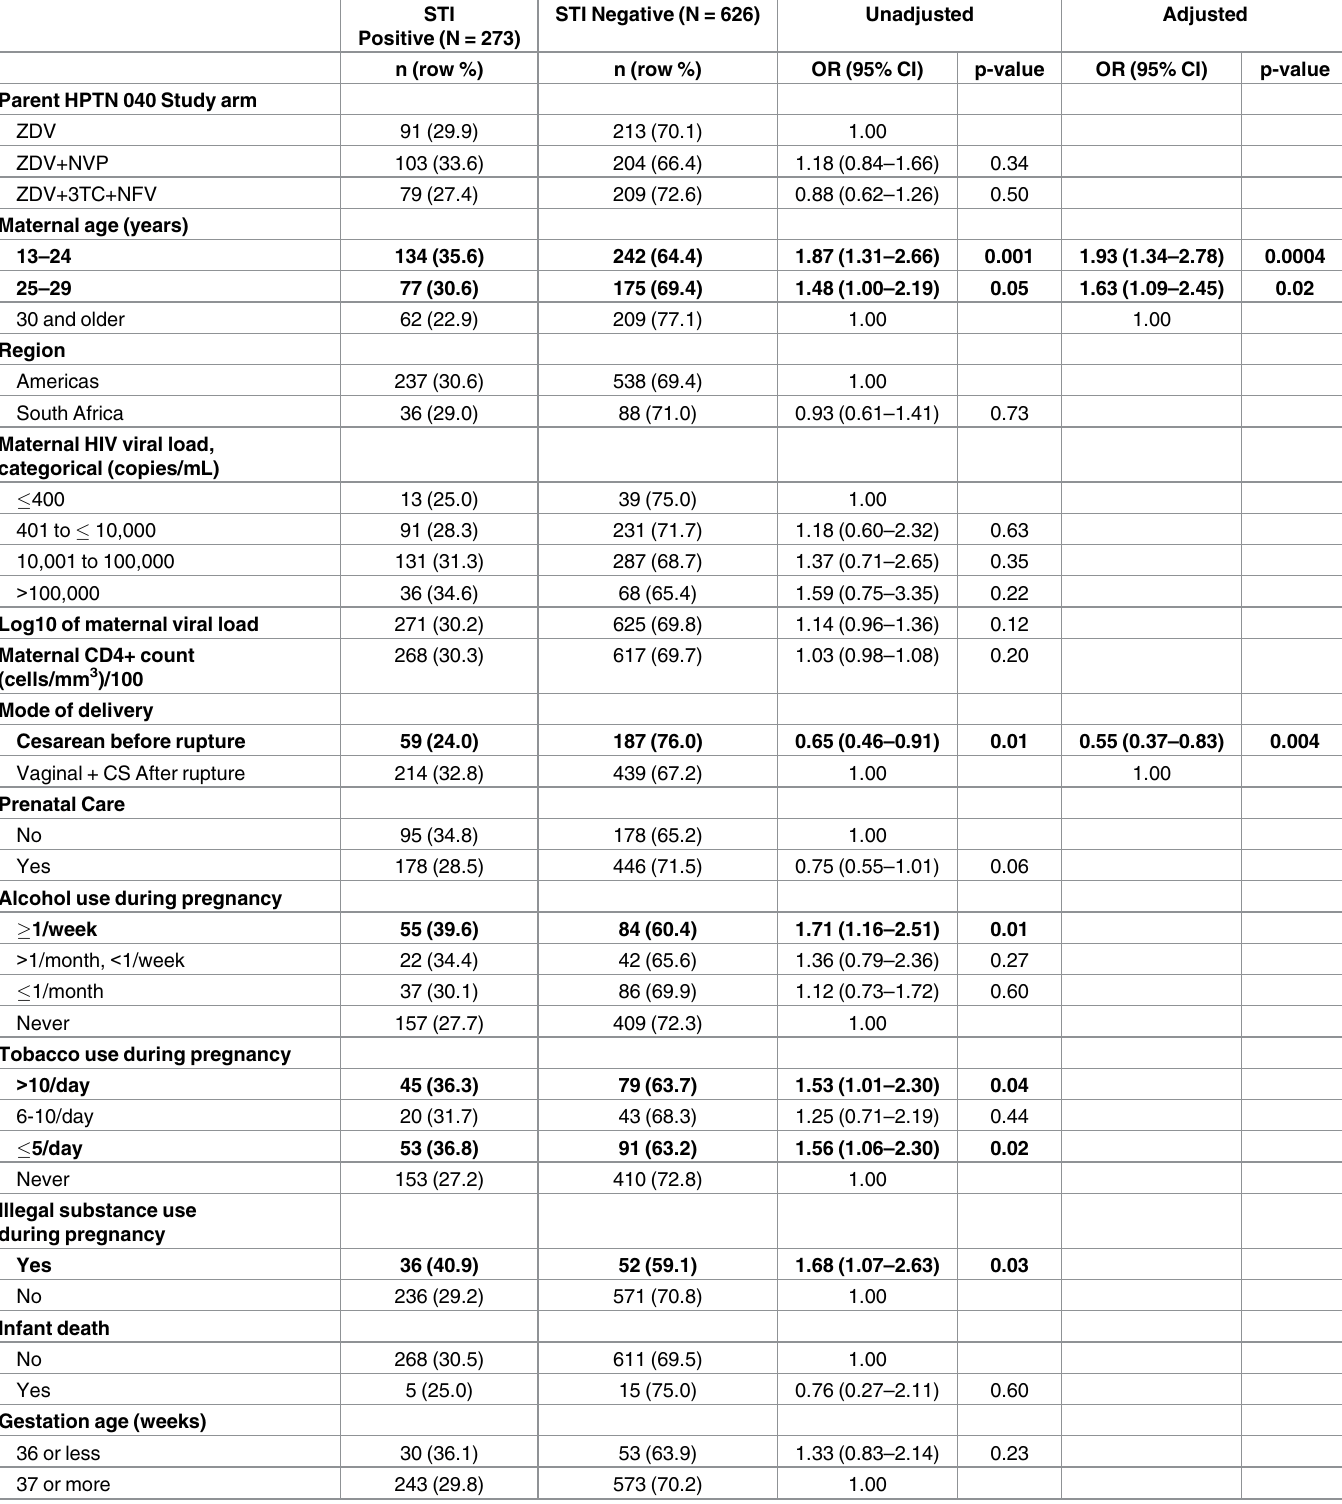
Table 2. Correlates and outcomes associated with having Any Maternal STI [Syphilis (TP), chlamydia (CT), gonorrhea (NG) or